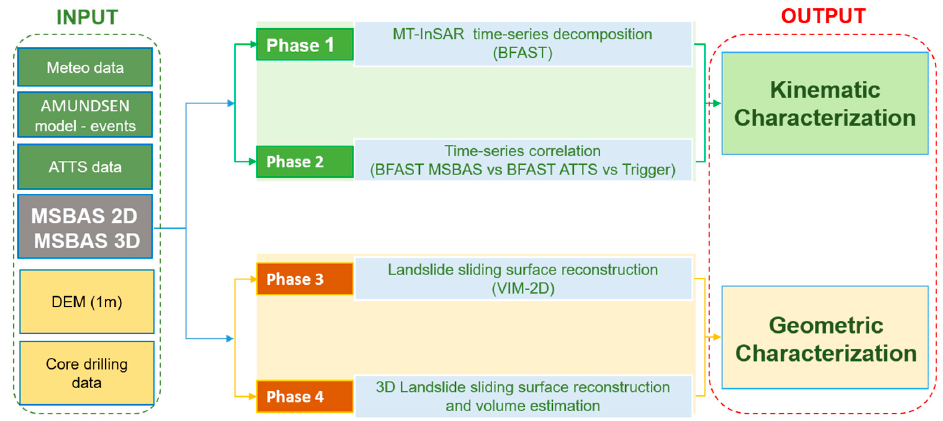
Figure 6. The workflow of the adopted methodology.